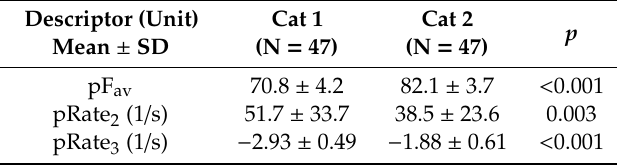
Table 5. Significant di ff erences between two categories of